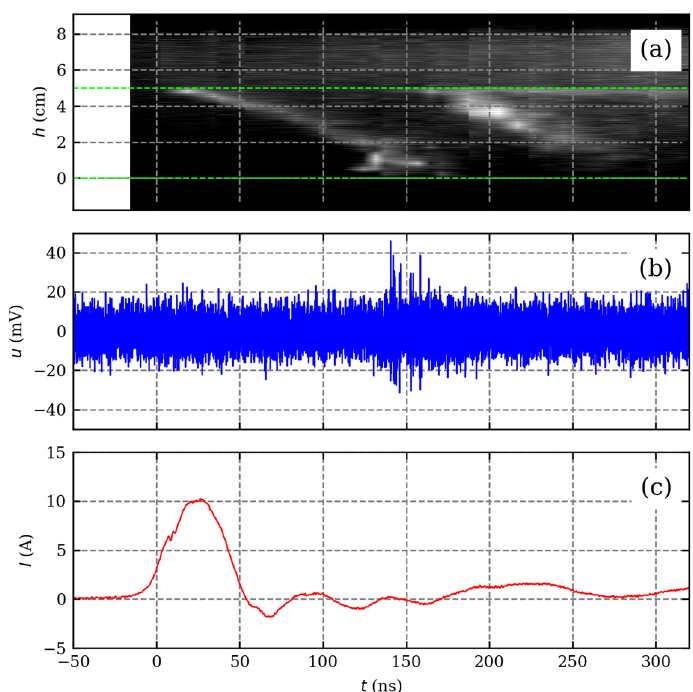
Figure 4. ( a ) Diagram representing the time dependence of the integral intensity of the discharge glowing at specified heights over the cathode; ( b ) waveform of the signal registered with horn antenna; and ( c ) waveform of the current running from the cathode to the ground. The potential difference between the anode and the ground is 35 kV.